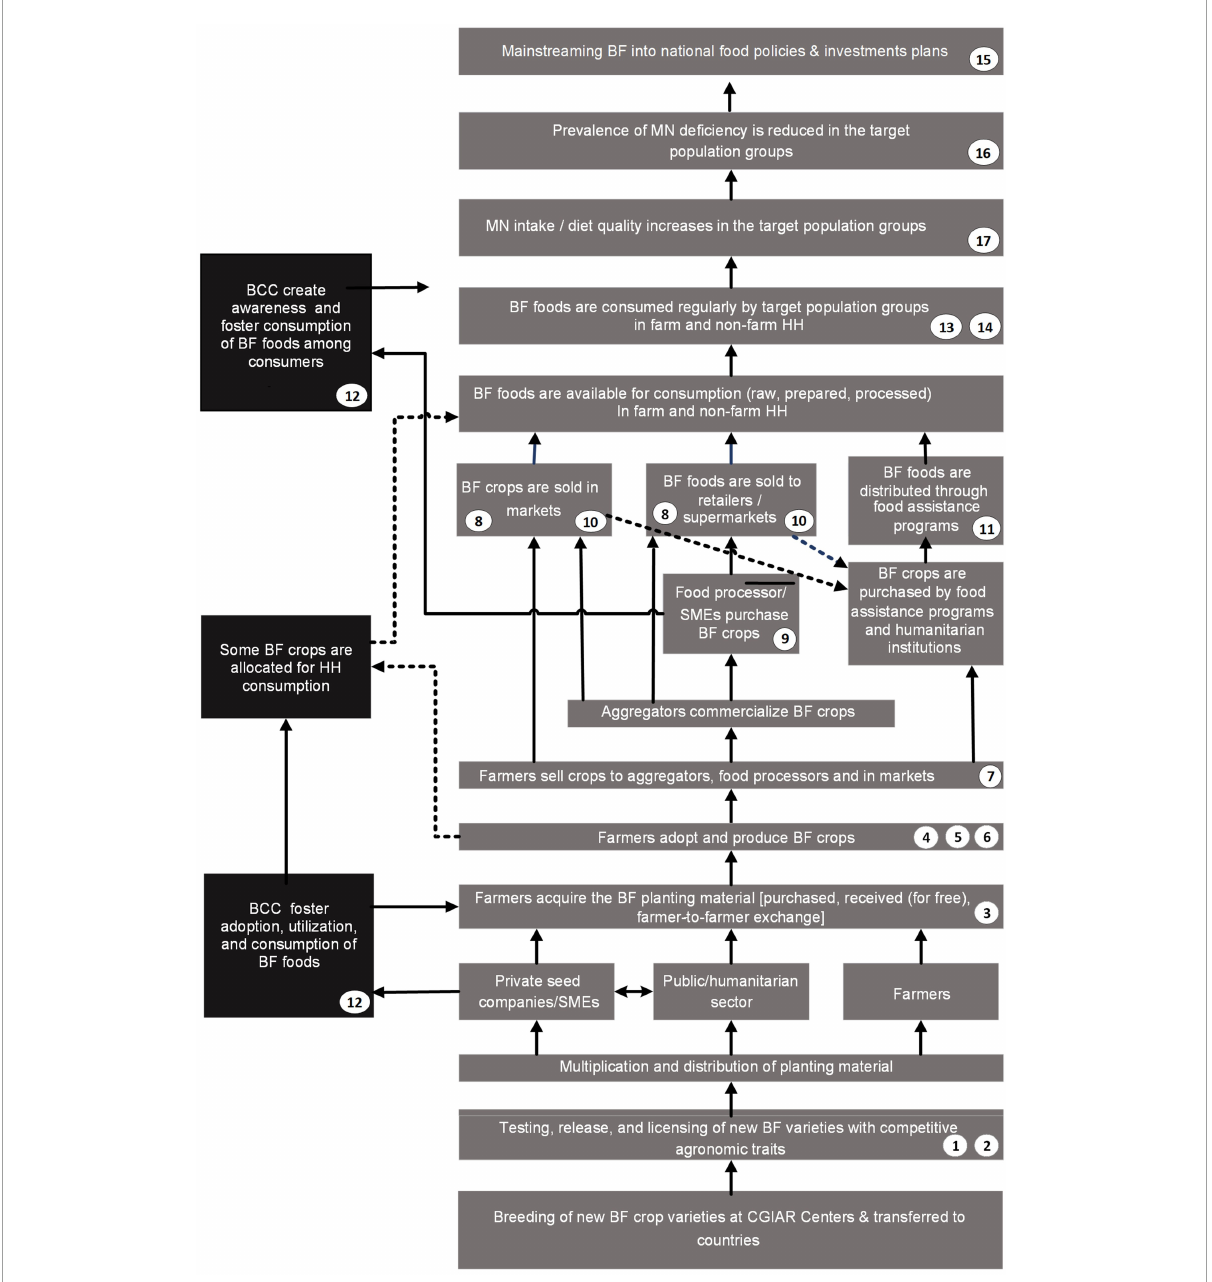
FIGURE2 Theory of Change representing the generic biofortification program impact pathway; the numbers in white circles correspond to the indicators shown in Table 6